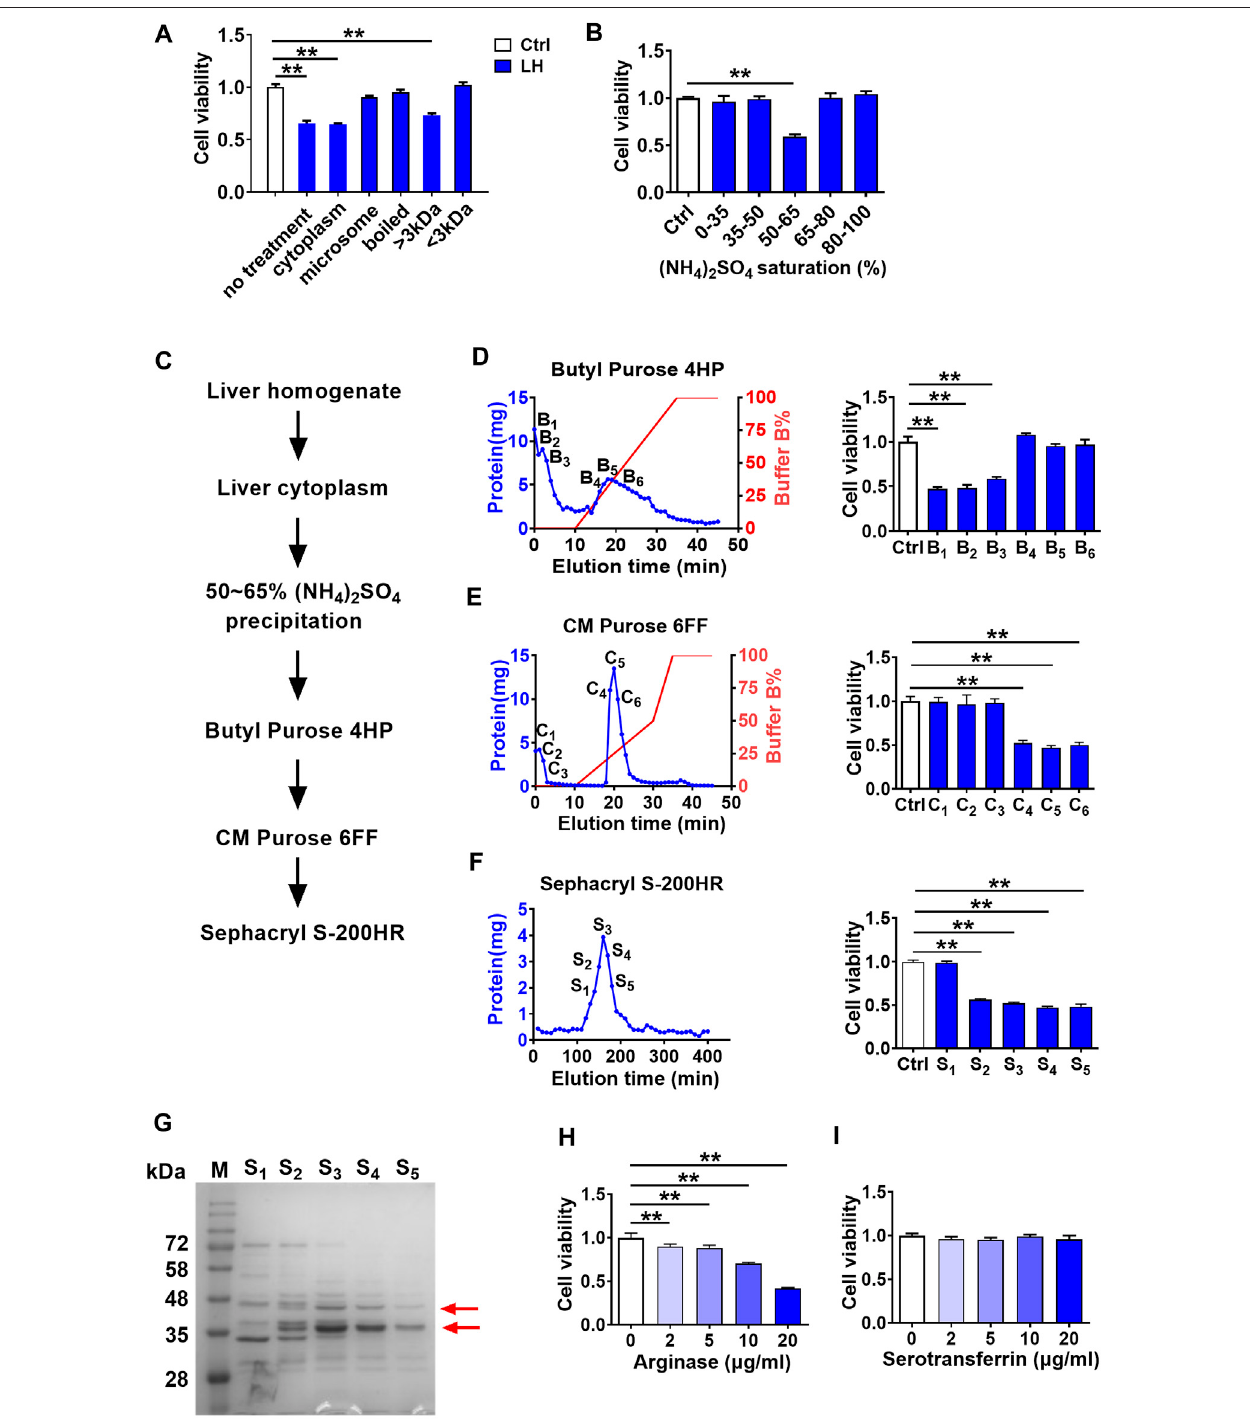
FIGURE 2 | Screening and identi fi cation of damage molecule to BBB in liver homogenate using hCMEC/D3 cells. (A) Effect of liver homogenate with different treatments on hCMEC/D3 cell viability ( n (cid:2) 4). (B) Effect of fractional (NH 4 ) 2 SO 4 precipitation of rat liver homogenate on hCMEC/D3 cell viability ( n (cid:2) 4). (C) Puri fi cation scheme for a toxic molecule to BBB from rat liver homogenate. (D) Elution curves of proteins in liver homogenate separated by columns of Butyl Purose 4HP, (E) CM Purose 6FF,and (F) Sephacryl S-200HR (blue line: protein quantity;red line:gradientelution procedure) and the effects of fractions elutedwith high abundance on hCMEC/D3 cell viability ( n (cid:2) 4). (G) Electrophoresis image of the fi nal puri fi ed protein samples stained by Coomassie Brilliant Blue (M: molecular weight marker; red arrows indicated bands selected to apply protein identi fi cation). (H) Effect of arginase and (I) serotransferrin on hCMEC/D3 cell viability ( n (cid:2) 4). Data were expressed as mean ± SD. ** p < 0.01 versus control cells (Ctrl); 1-way ANOVA followed by Dunnett ’ s post hoc test.